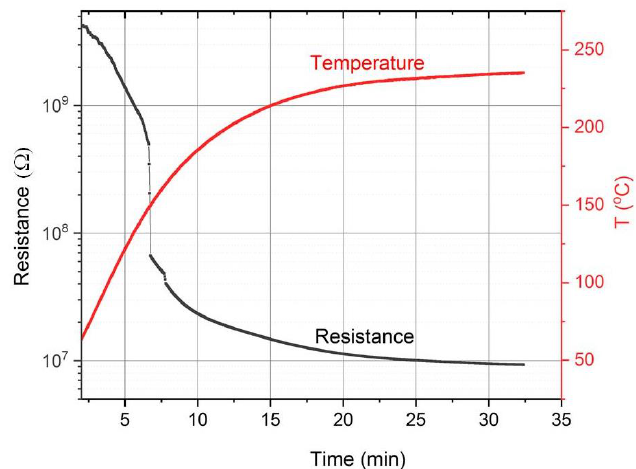
Figure 6. An example of transformation of GO into rGO by annealing in atmospheric air.